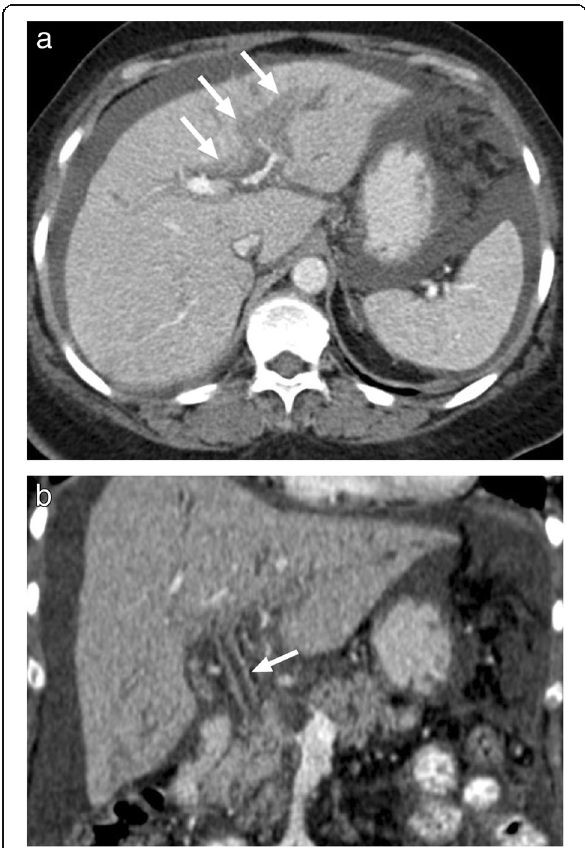
Fig. 25 A 68-year-old female with known remote history of breast cancer. The patient recently started to experience abdominal pain, distention, night sweets and weight loss. a Axial plane postcontrast CT demonstrated prominent periportal thickening (arrows) in the left liver lobe which may also be seen in infiltrative liver malignancies such as lymphoma. b Coronal reformatted image shows significant contrast enhancement in the common bile duct (arrow). Also note moderate ascites with mild peritoneal contrast enhancement which may also suggest peritoneal carcinomatosis. Intraabdominal fluid sampling and cytology confirmed biliary TB